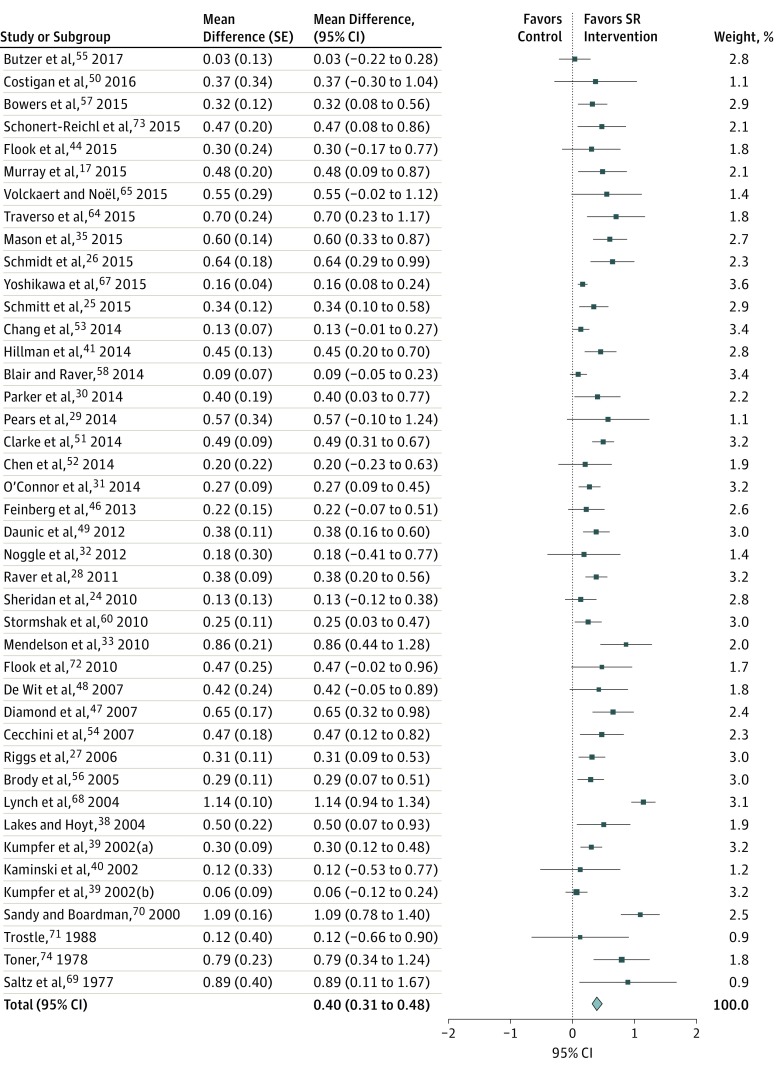
Forest Plot of Intervention ResultsData were pooled under the assumption of a random-effects model; τ2 = 0.05; χ241 = 178.14; P < .001; I2 = 77%; overall effect z = 9.16; P < .001. Kumpfer et al39 includes 2 separate analyses. SR indicates self-regulation.